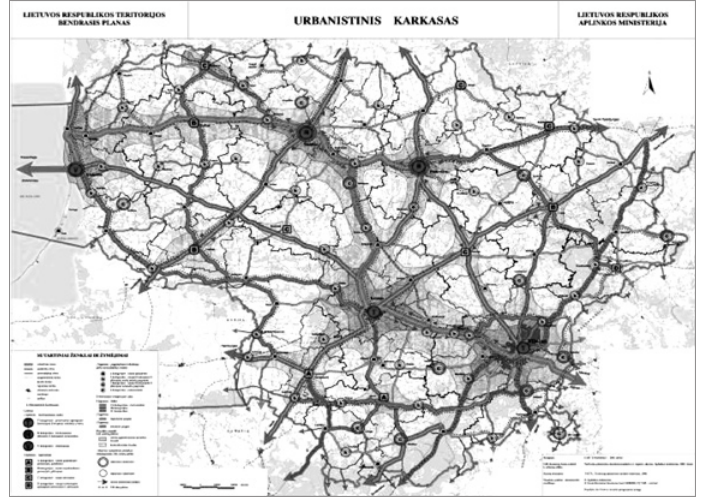
Fig. 1. Scheme of the Comprehensive Plan of the territory of the Republic of